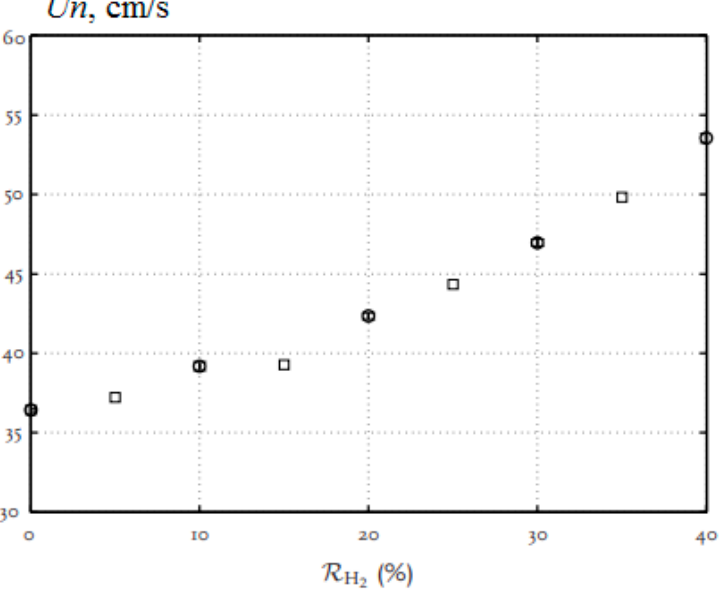
Figure 5. Dependence of the normal flame velocity Un of hydrogen–methane–air mixtures on the hydrogen concentration under normal conditions (Adapted from ref. [17]).